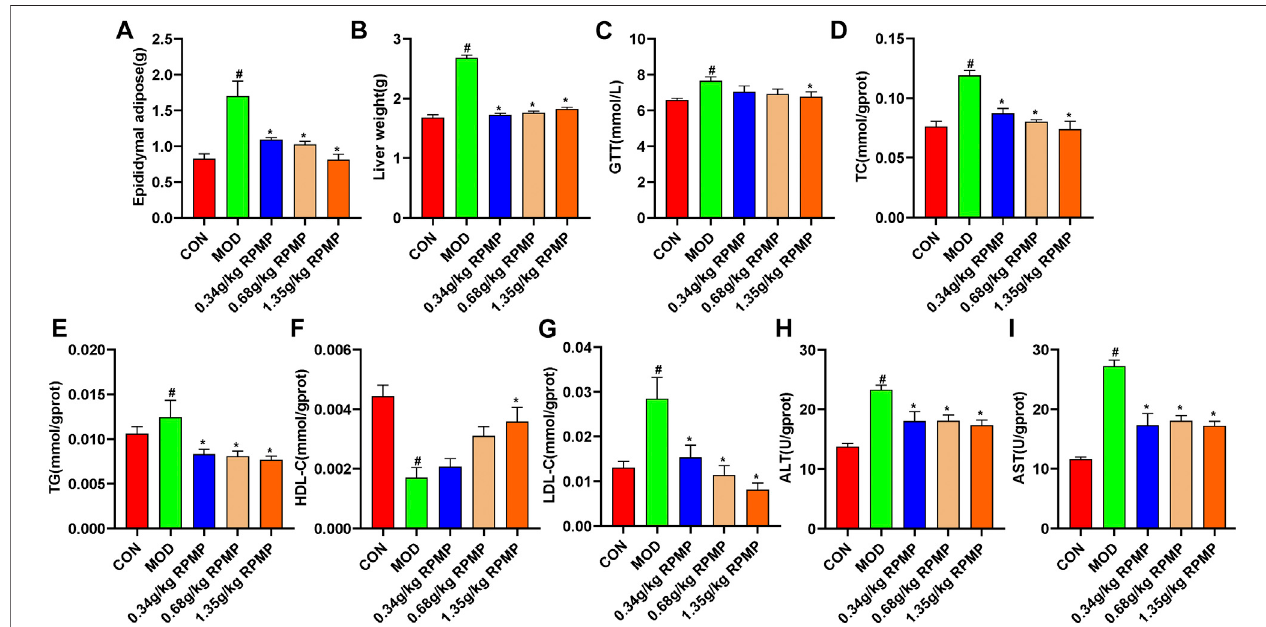
FIGURE 5 | Physiological and biochemical indices of mouse liver. (A,B) Liver physiological indicators. (C) Fasting blood glucose levels in mice. (D – I) Liver biochemical indicators. The data were presented as the means ± SEM, # p < 0.05, compared with the CON group; * p < 0.05, compared with the MOD group ( n (cid:2)